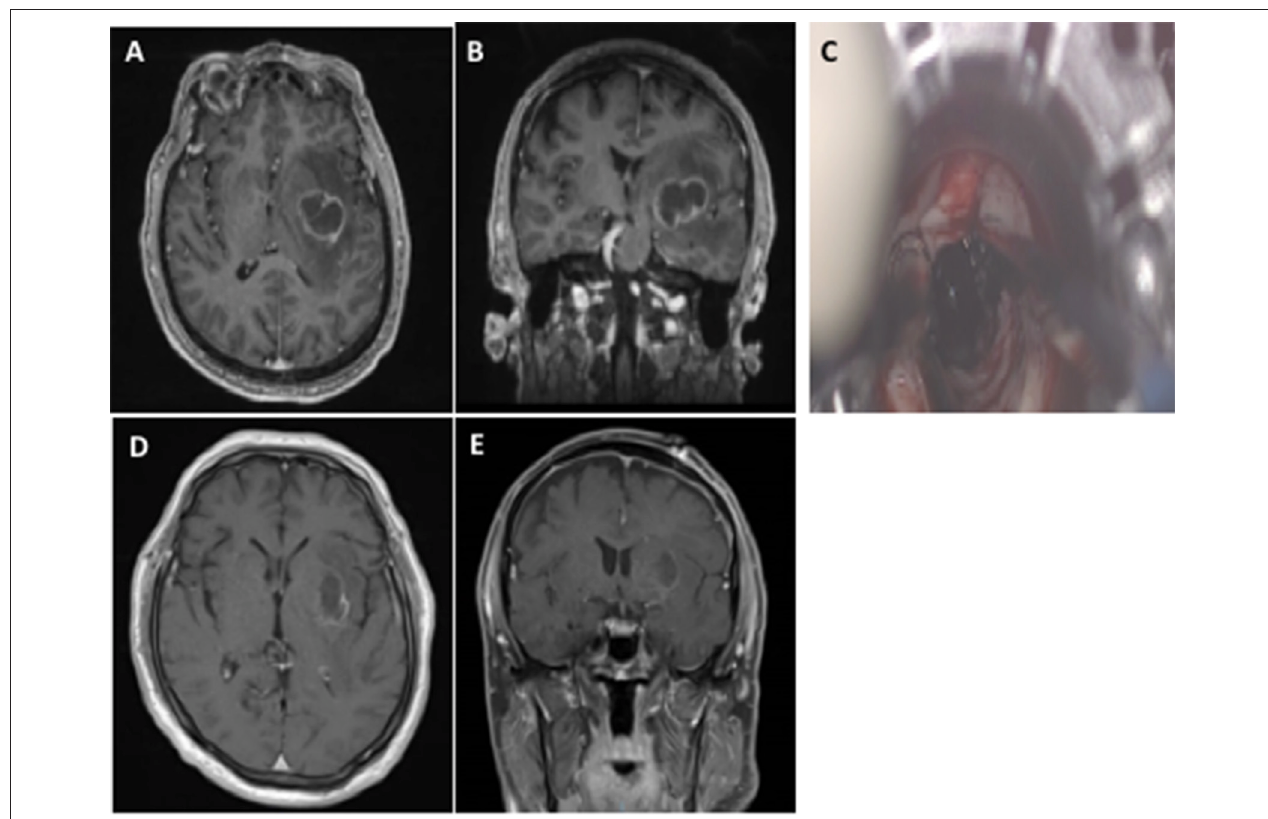
FIGURE 1 | The use of channel-based retractor of a left basal ganglia non-small cell lung cancer brain metastasis. Preoperative axial (A) and coronal (B) MRI with contrast demonstrating a deep-seated left basal ganglia brain metastasis. The use of a channel-based retractor to access the lesion (C) . Postoperative axial (D) and coronal (E) MRI with contrast demonstrating gross total resection and no superficial cortical and white matter changes.